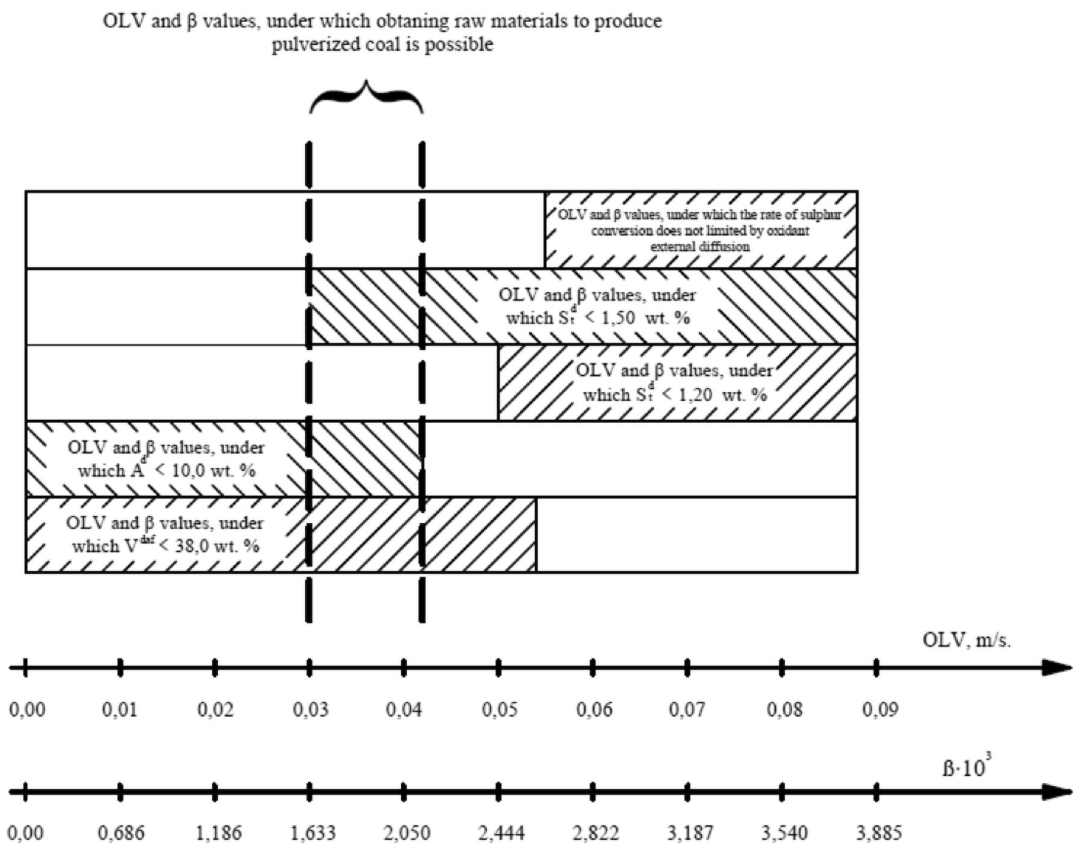
Fig. 9 OLV and b values, under which obtaning raw materials to produce pulverized coal is possible. Initial fraction 0.1–0.25